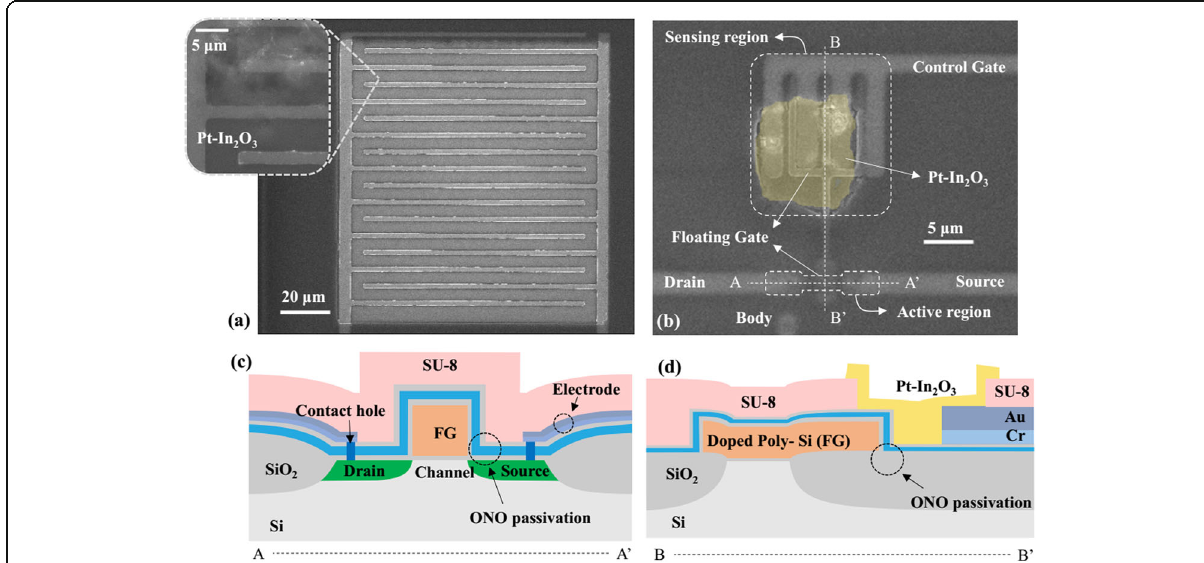
Fig. 1 The resistive-type and FET-type gas sensors with inkjet-printed Pt-In 2 O 3 nanoparticles. a SEM image of the resistive-type sensor platform. The inset shows magnified electrodes after forming the Pt-In 2 O 3 sensing layer. b SEM image of the FET-type sensor with a FG aligned with a CG horizontally. c The schematic cross-sectional view along line A – A ’ in b . d The schematic cross-sectional view along line B – B ’ in b . The channel length and width are 2 μ m and 2.4 μ m,